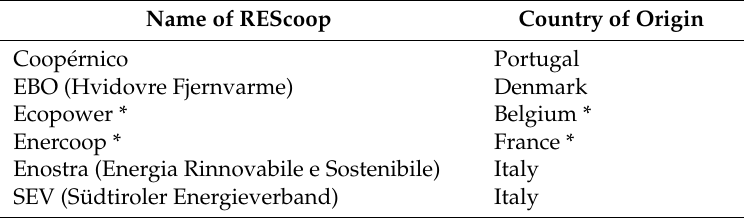
* Data used in present